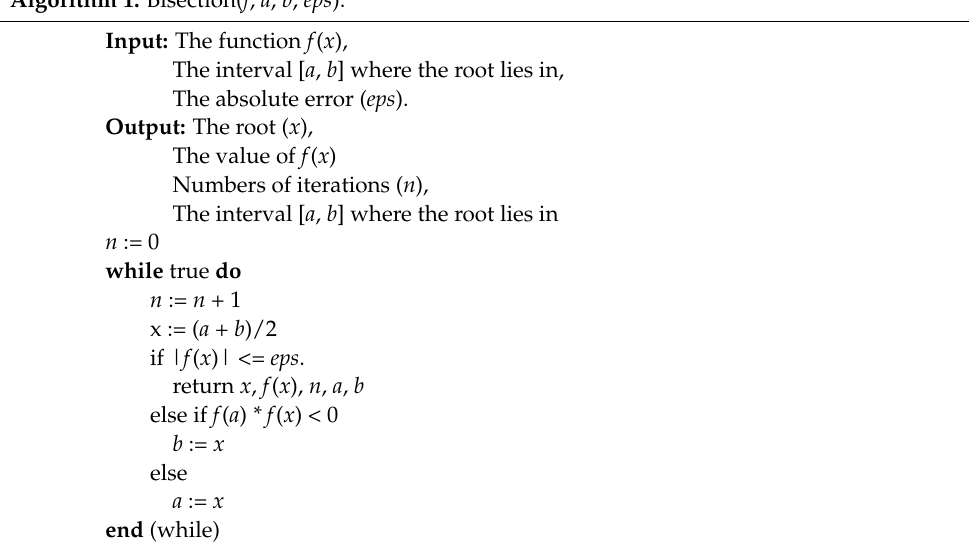
Algorithm 1. Bisection( f , a , b , eps ).